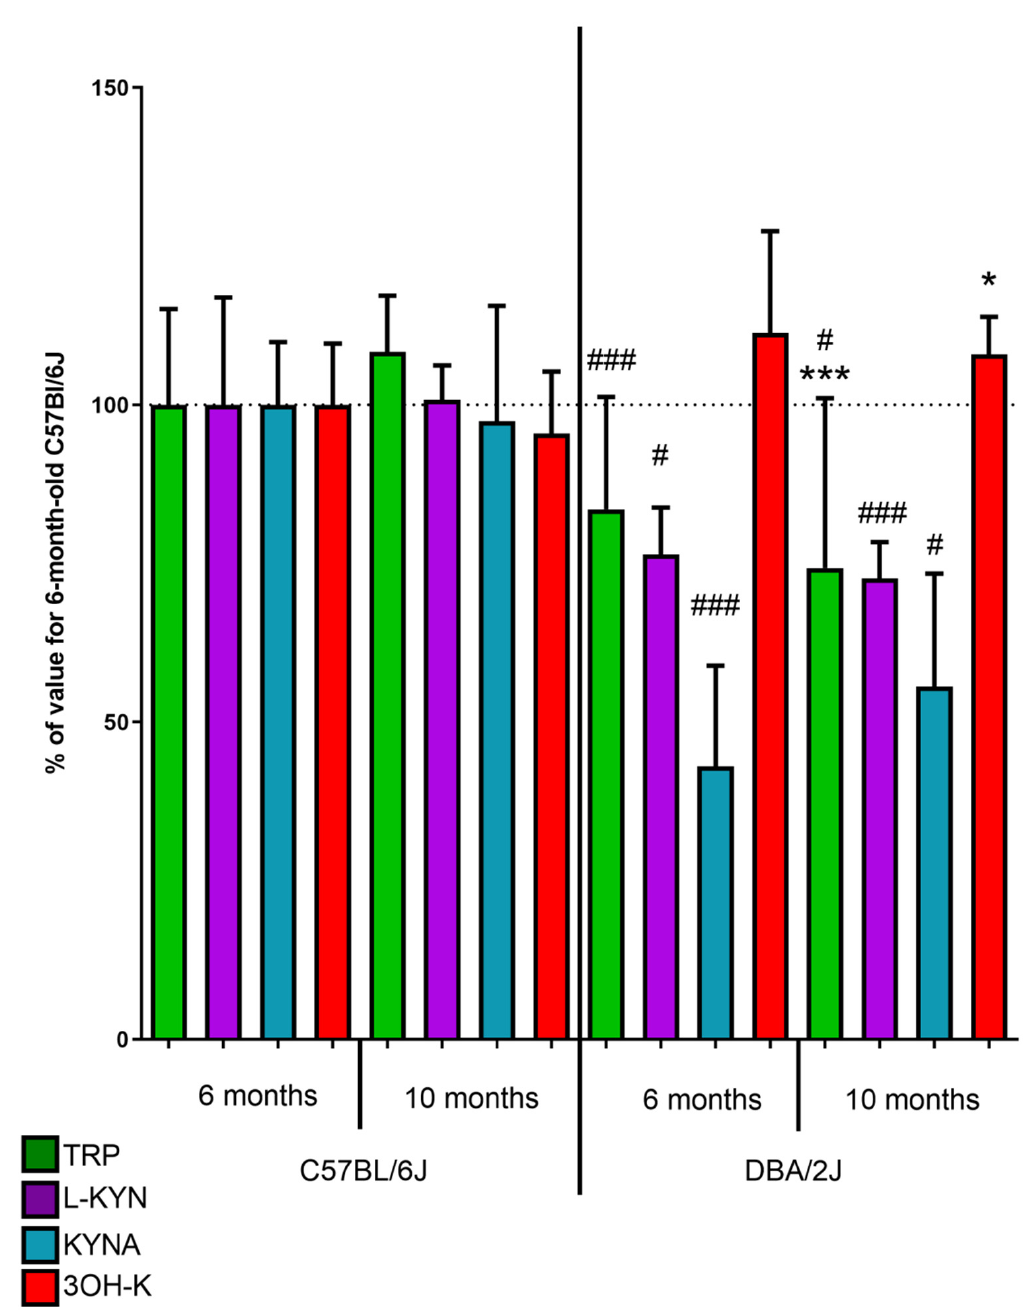
Figure 3. The levels of tryptophan (TRP), L-kynurenine (L-KYN), kynurenic acid (KYNA), and 3-hydroxykynurenine (3OH-K) in the serum of C57BL/6 and DBA/2J mice. Values are expressed as a percentage of TRP, L-KYN, KYNA, or 3-OH-K concentrations in samples from 6-month-old C57Bl/6 mice. # p < 0.05, ### p < 0.001 DBA2J vs. C57Bl/6; * p < 0.05, *** p < 0.001 10 months vs. 6 months.